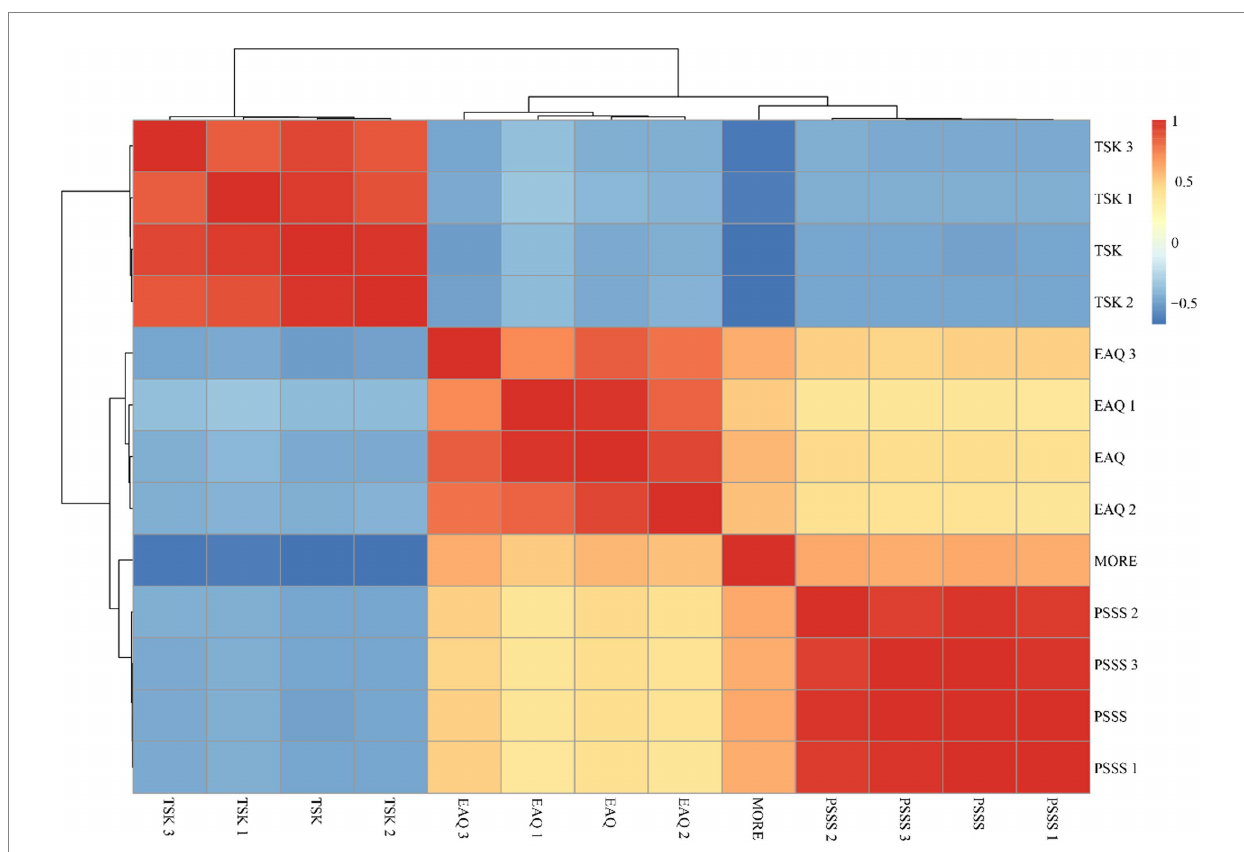
FIGURE 1 Correlation analysis of perceived social support, exercise adherence, kinesiophobia, and motivation for rehabilitation in older adult patients with stroke. PSSS: perceived social support total score; PSSS 1: family support; PSSS 2: friend support; PSSS 3: other support; EAQ: exercise adherence total score; EAQ 1: physical exercise adherence; EAQ 2: exercise monitoring adherence; EAQ 3: active advice seeking adherence; TSK: kinesiophobia total score; TSK 1: activity behavior; TSK 2: activity cognitive; TSK 3: activity attitude; MORE: total stroke rehabilitation motivation score.